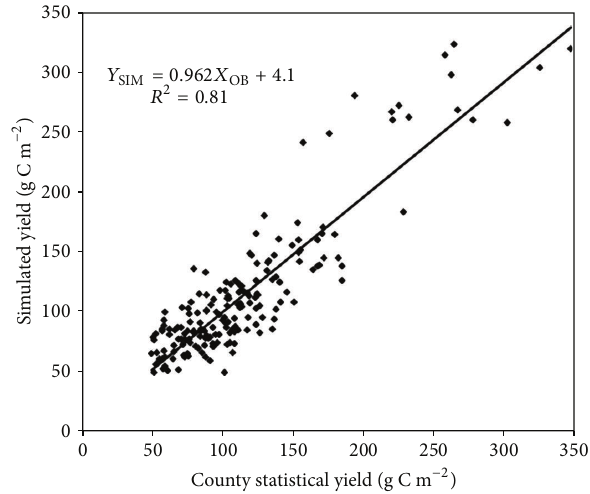
Figure 2: Comparison of simulated crop yields (of corn, oats, soybean, spring wheat, and sunflower) and USDA county statistical yields across the study area from 1972 to 2007.